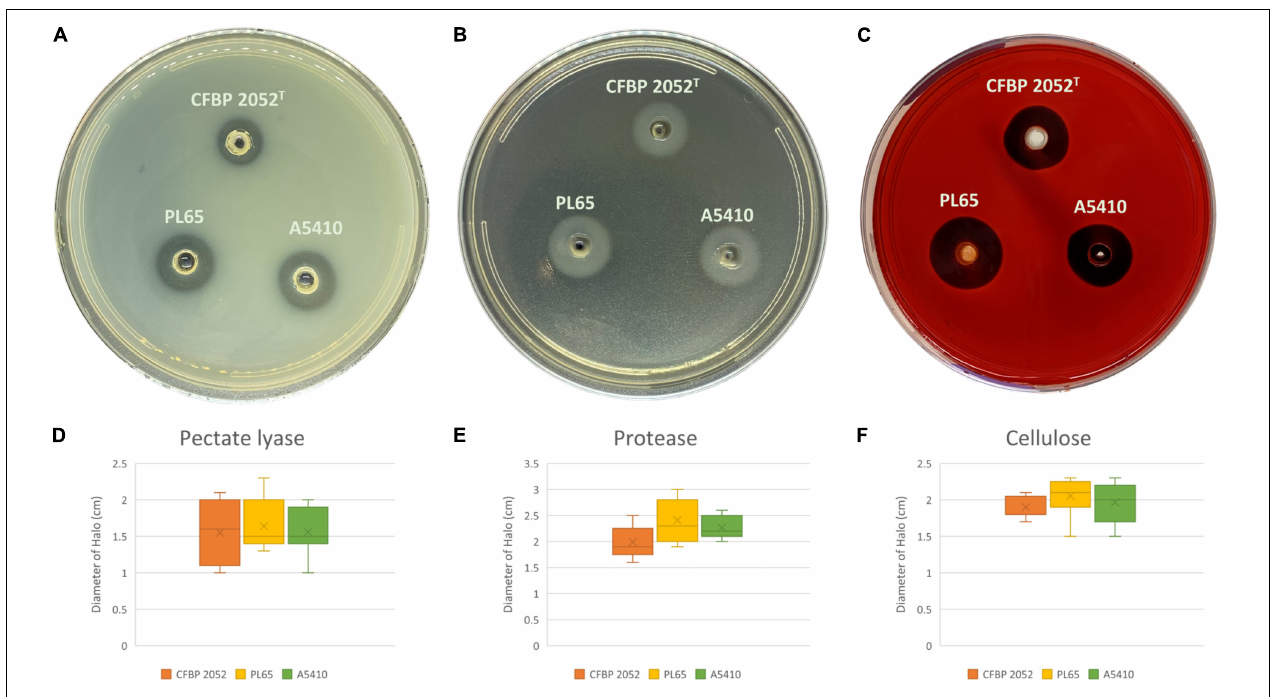
FIGURE 10 | Extracellular cell wall-degrading enzymes produced by three D. zeae strains. The three D. zeae strains assayed on the (A) pectate lyase (Pel), (B) protease (Prt), and (C) cellulose (Cel) plates. Samples of 50 µ l of overnight culture were added to the assay plate wells (3 mm in diameter) and incubated at 28 ◦ C. The Pel assay plates were treated with 4 N HCl after 10 h. The Cel assay plates were stained with 0.1% (w/v) Congo red for 10 h and decolored with 5 M NaCl. The Prt assay plates were observed after 24 h without any further treatment. (D–F) indicate the production of Pel, Prt, and Cel from D. zeae strains,